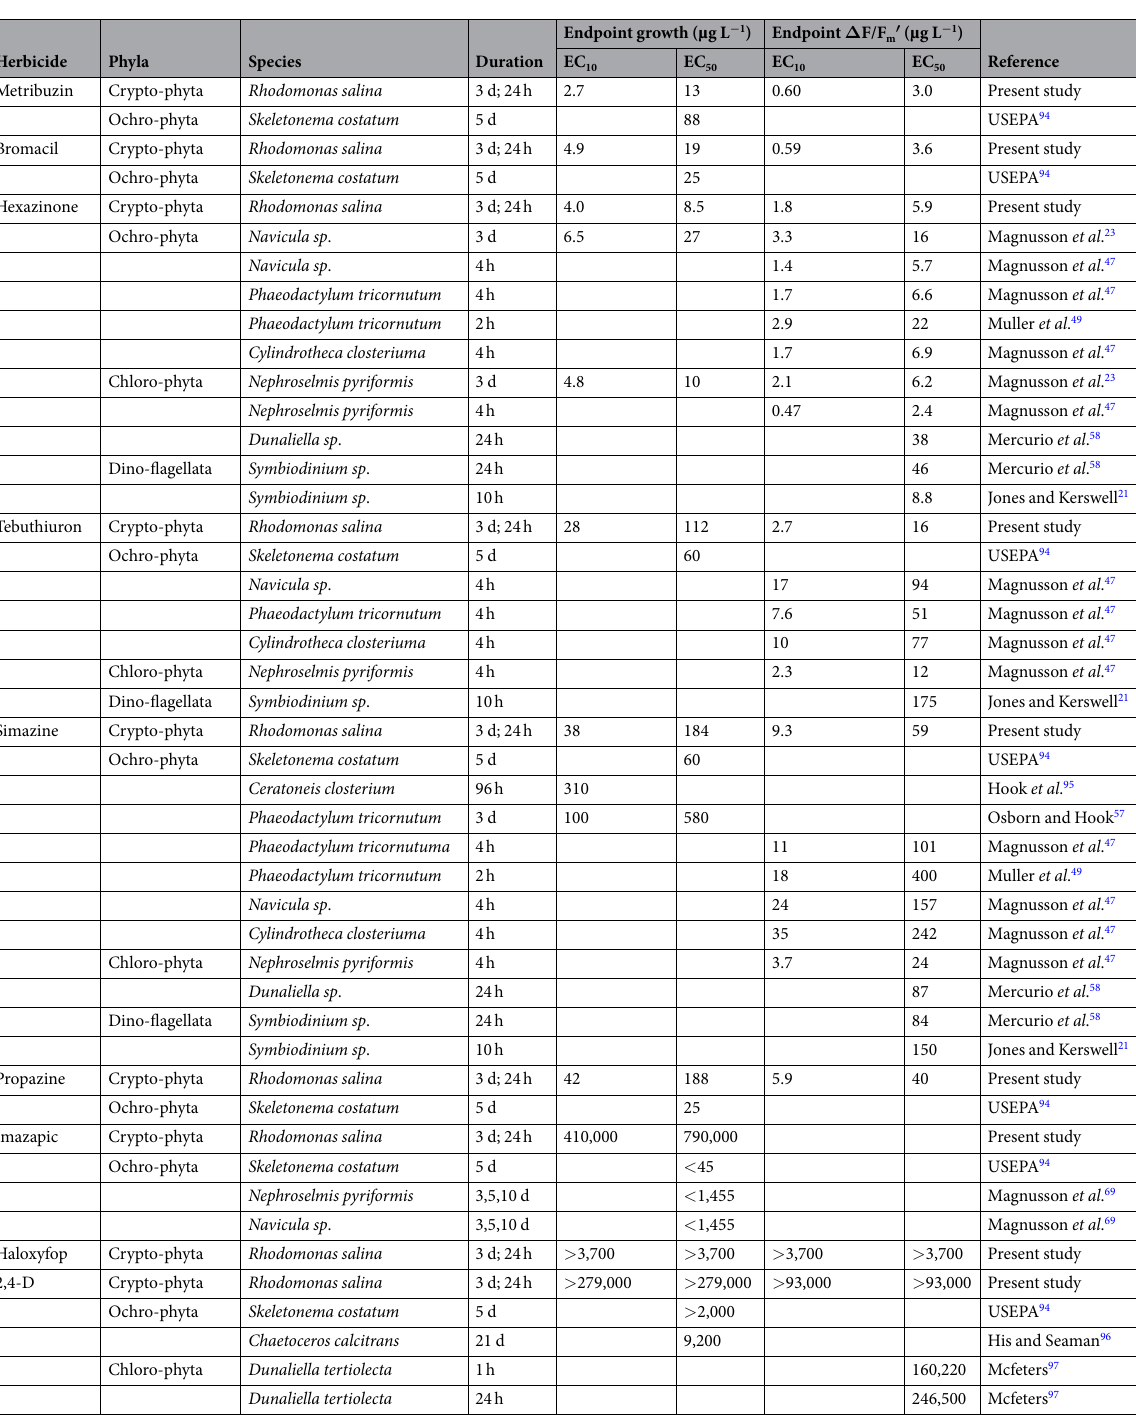
Table 4. Toxicity values for Rhodomonas salina and other marine microalgae. Herbicide toxicity to microalgae including data from the United States Environmental Protection Agency (USEPA) ECOTOX Database 94 and other publications using similar methods as those used in the present study (i.e. experimental conditions, ecological